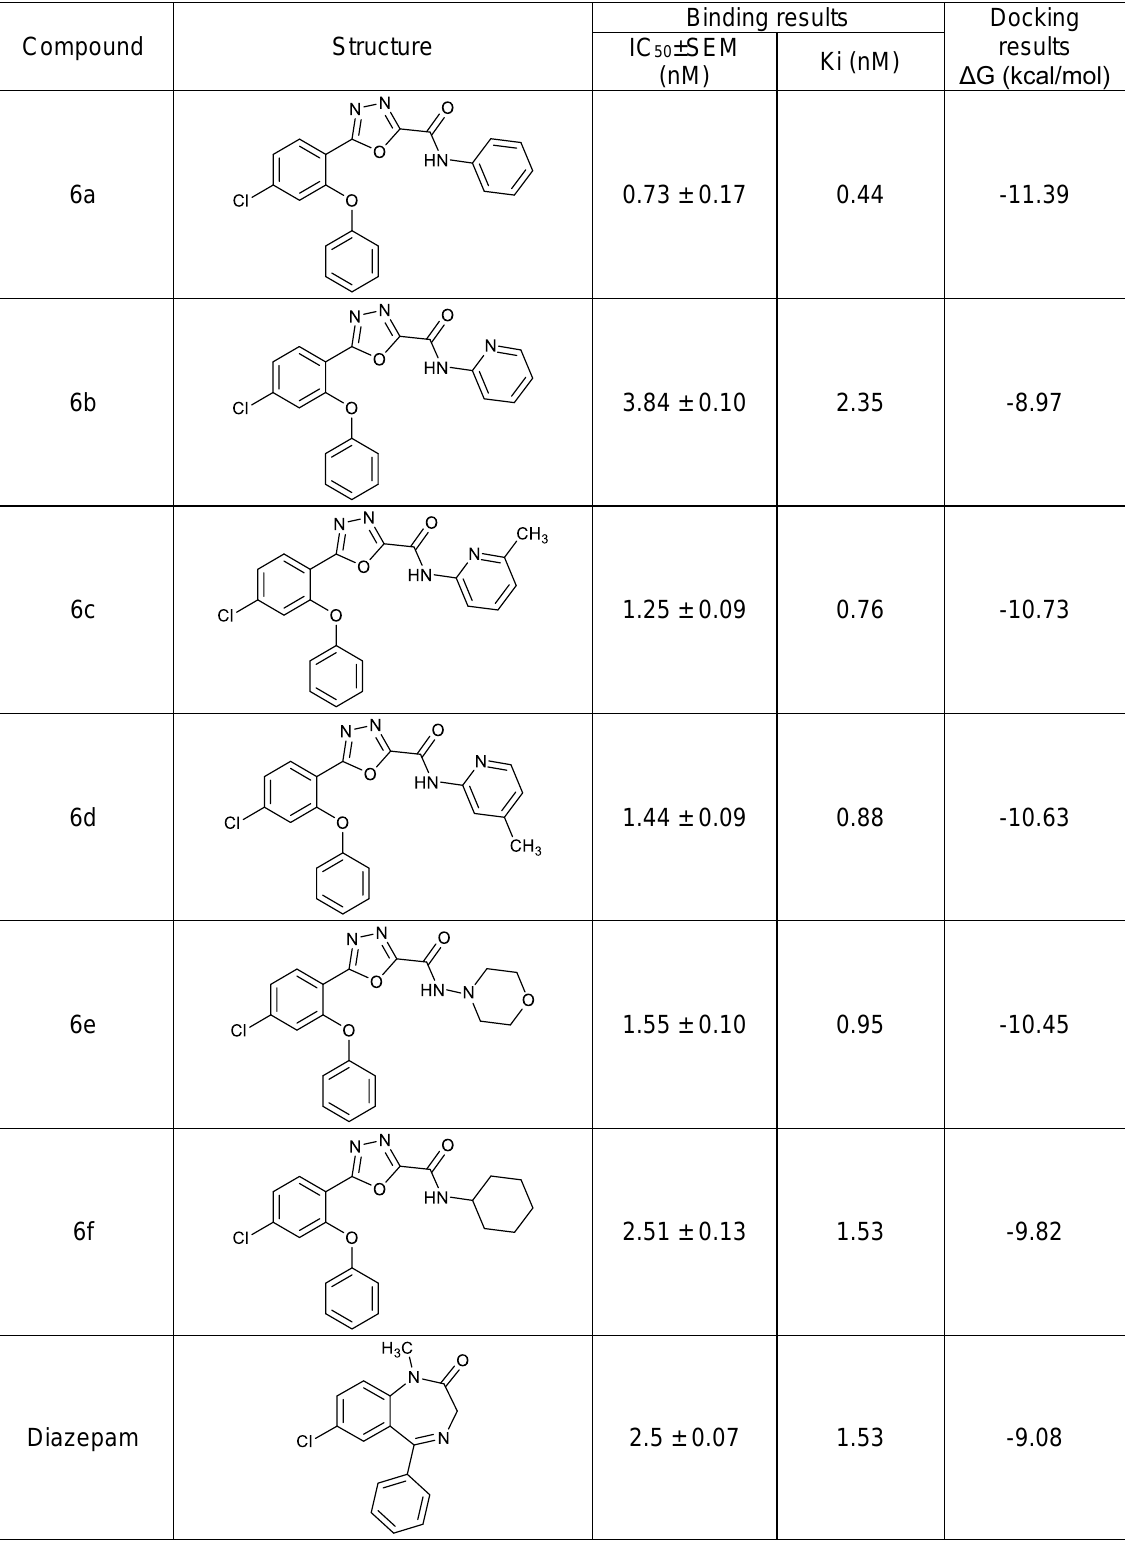
Table 1: In vitro binding affinities (IC 50 , ki) and docking study results (ΔG) of the novel